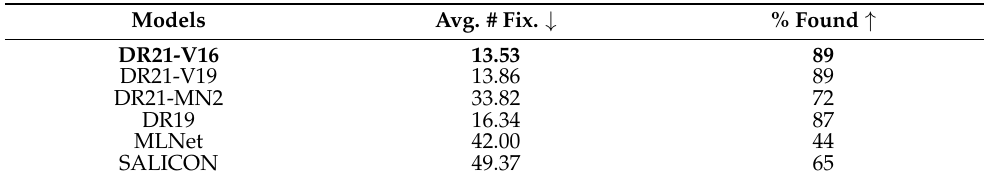
Table 10. Comparing results on P 3